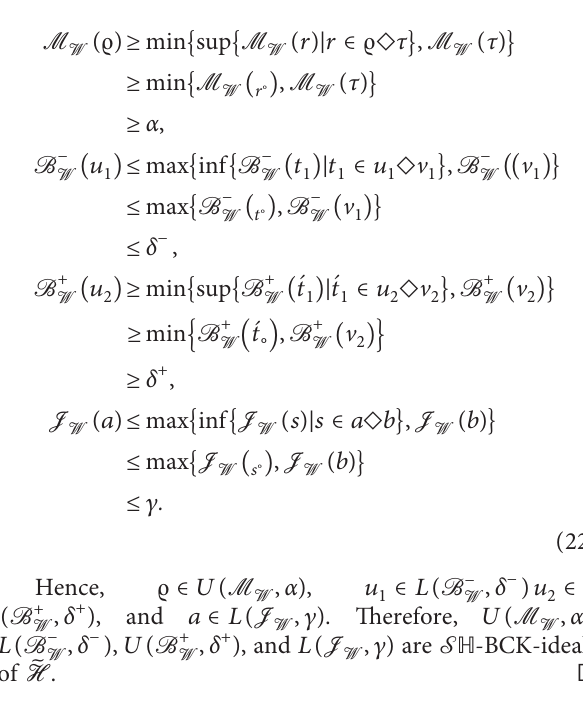
Table 6: Tabular representation of W � ( M